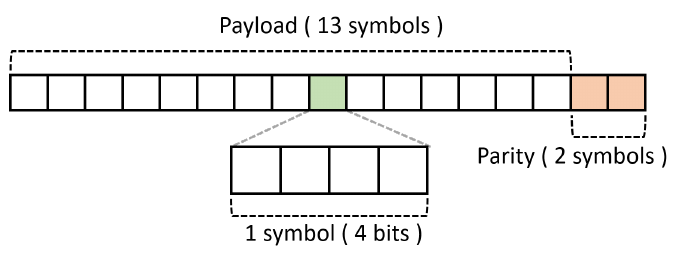
Figure 4. Code-word of Reed–Solomon code (RS) (15,13)